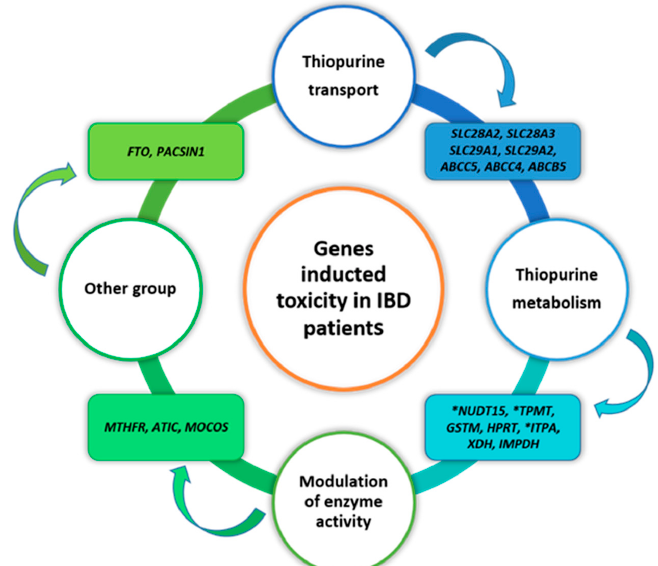
Figure 4. Potential genes inducing cytotoxicity in IBD patients. Explanation of abbreviations: *— widely characterized impact; SLC28A2 —solute carrier family 28 member 2; SLC28A3 —solute carrier family 28 member 3; SLC29A1 —solute carrier family 29 member 1; SLC29A2 solute carrier family 29 member 2; ABCC5 —ATP binding cassette subfamily C 28 member 5; ABCC4 —ATP binding cassette subfamily C member 4; ABCB 5—ATP binding cassette subfamily B member 5; NUDT15 —nudix hy- drolase 15; TPMT —thiopurine S-methyltransferase; GSTM —glutathione S-Transferase Mu;